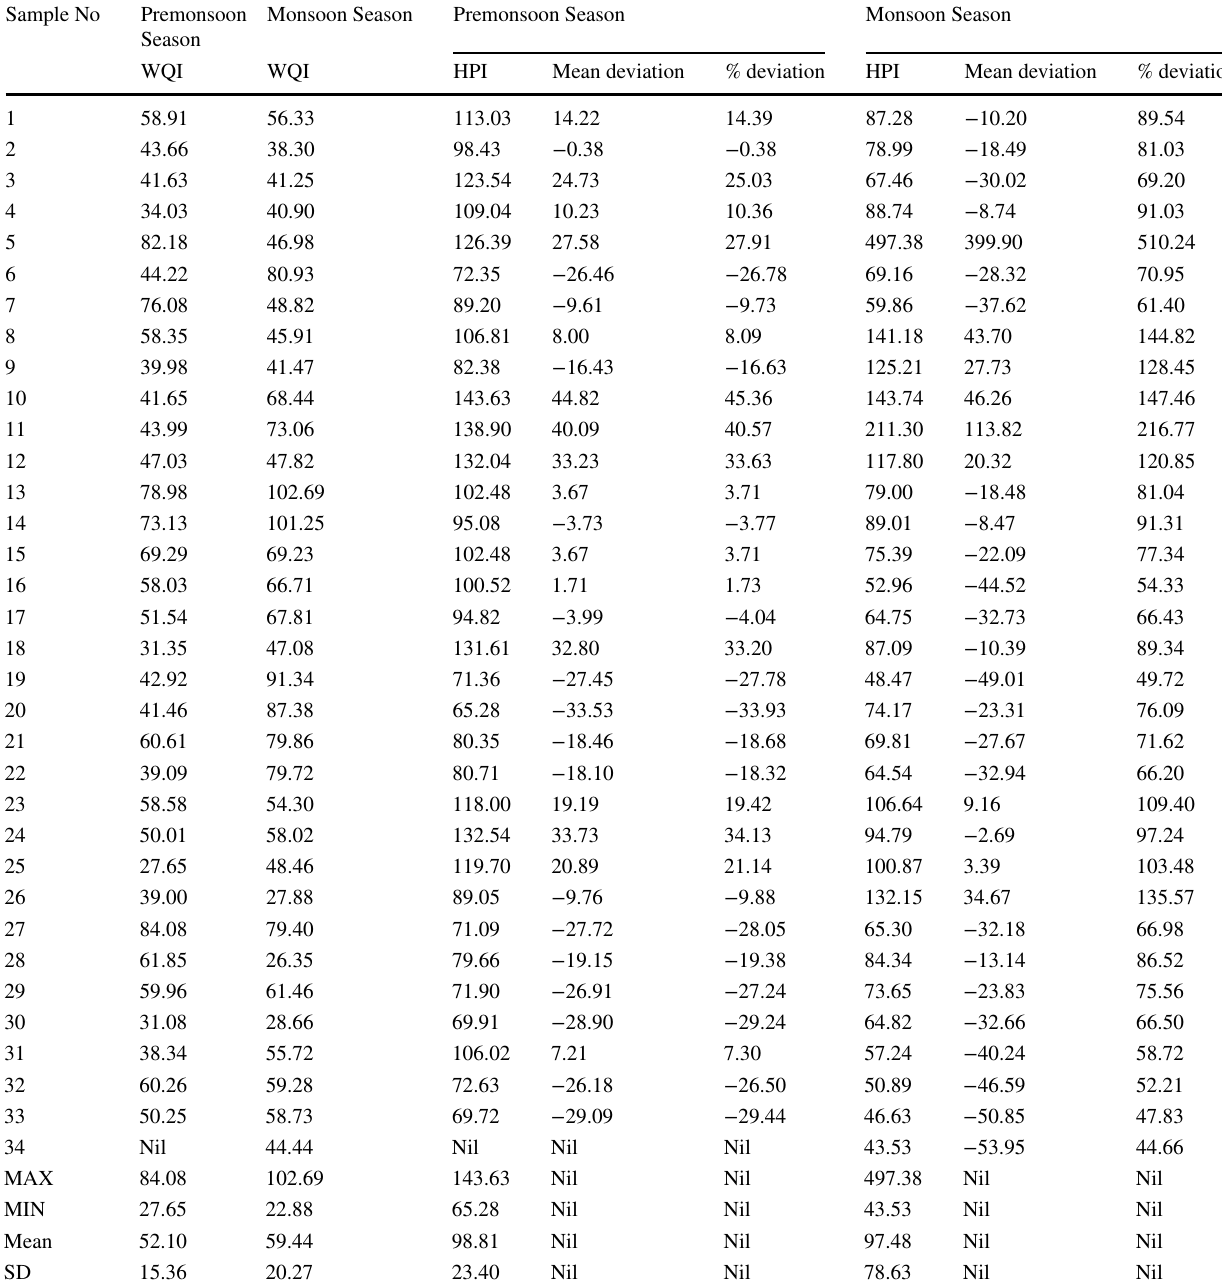
Table 5 Details of WQI and Mean-based reclassification methods based on HPI of water samples in Premonsoon and Monsoon